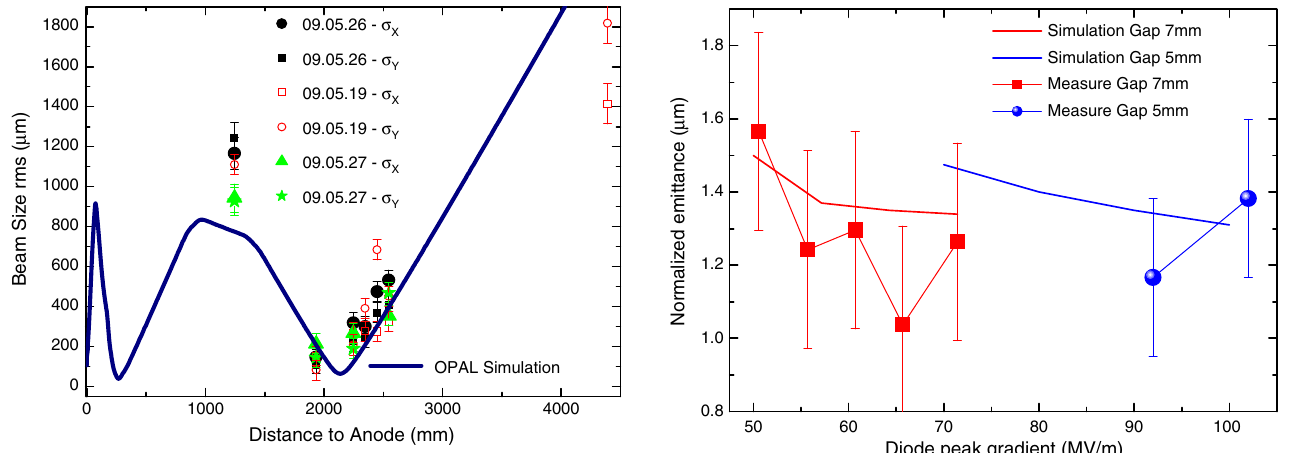
FIG. 9. Simulations of the transverse electron beam size (rms) along the machine axis compared to measurements on different days. ( (cid:5) mc 2 ¼ 4 : 911 MeV ; Q ¼ 10 pC ; D